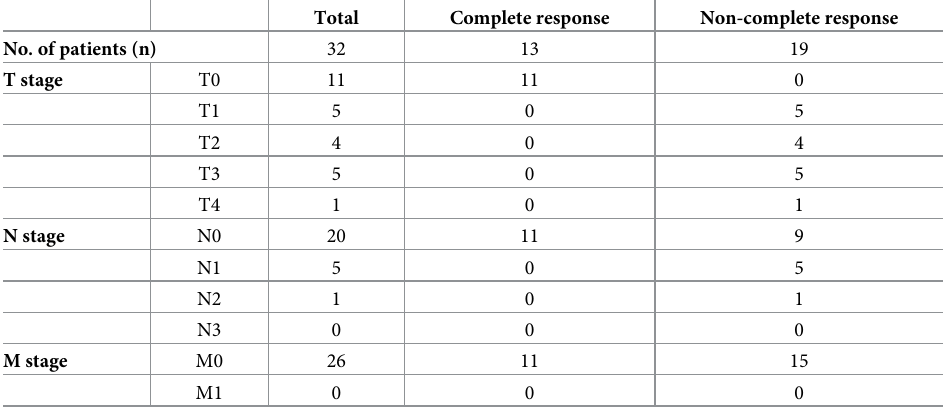
Table 2. Clinicopathological characteristics of patients with esophageal cancer after neoadjuvant